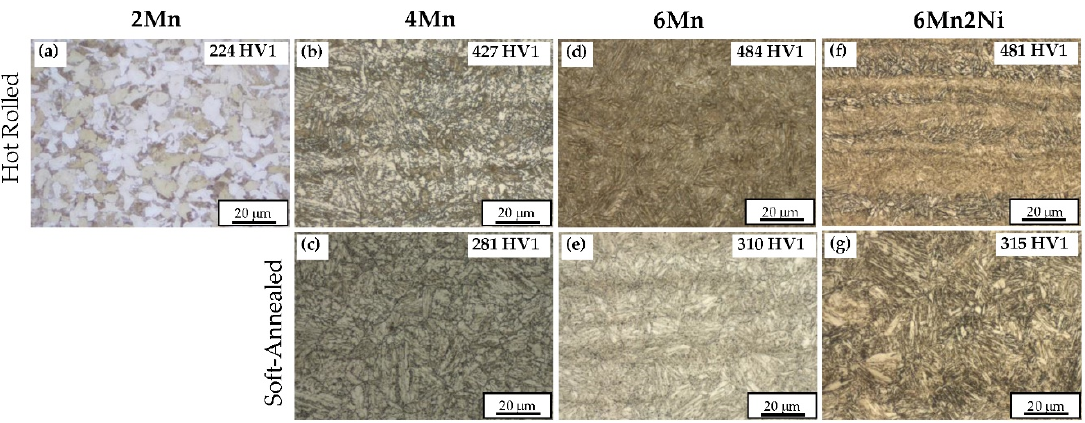
Figure 2. Light optical metallography (LOM) images and hardness of the hot strip microstructures. ( a ) Alloy 2 Mn after hot rolling; ( b ), ( d ), and ( f ) alloys 4Mn, 6Mn, and 6Mn2Ni after hot rolling, respectively; ( c ), ( e ), ( g ) alloys 4Mn, 6Mn, and 6Mn2Ni after soft annealing, respectively.